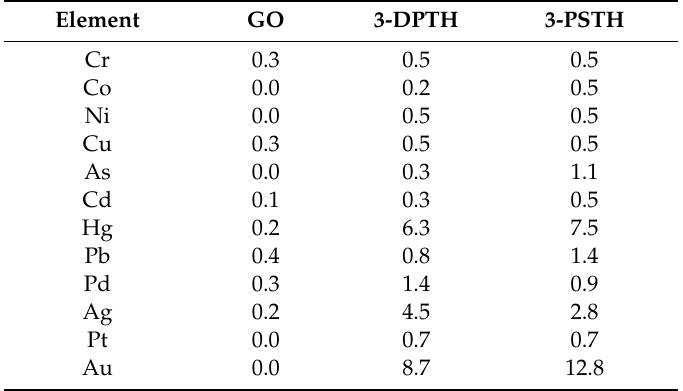
Table 5. Adsorption capacities of GO and materials synthesized by Method 3 at acid pH (mg / g).